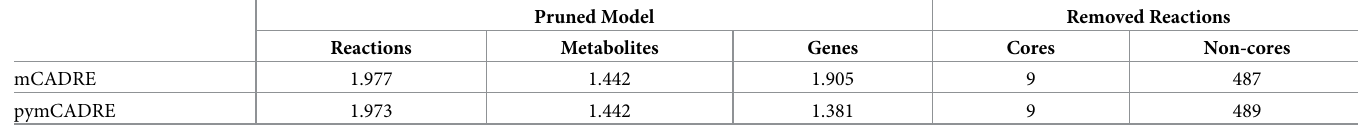
Table 1. Analysis results of the HBEC-specific reconstructions using FVA for internal optimizations. The reaction overlap between both models is over 99.5%.